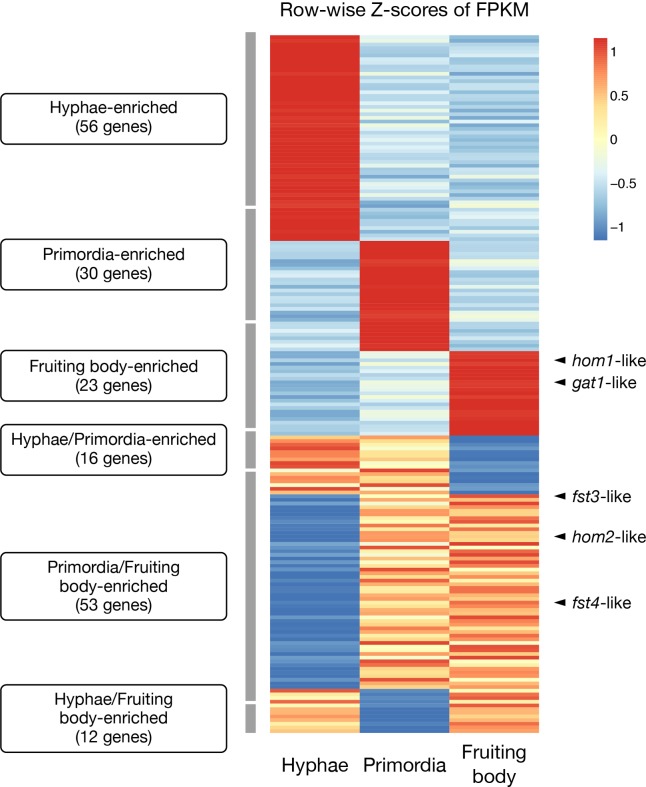
Transcription factor expressions at the three developmental stages.Differentially expressed genes were determined based on logFC (>1 or <−1), calculated by IsoEM2 and IsoDE2. When two conditions were more expressed than the other but there was no difference between them (−1 < logFC < 1), we assigned this gene as being co-overexpressed in these two conditions. Row-wise Z-scores of fragments per kilobase of transcript per million mapped reads were used.